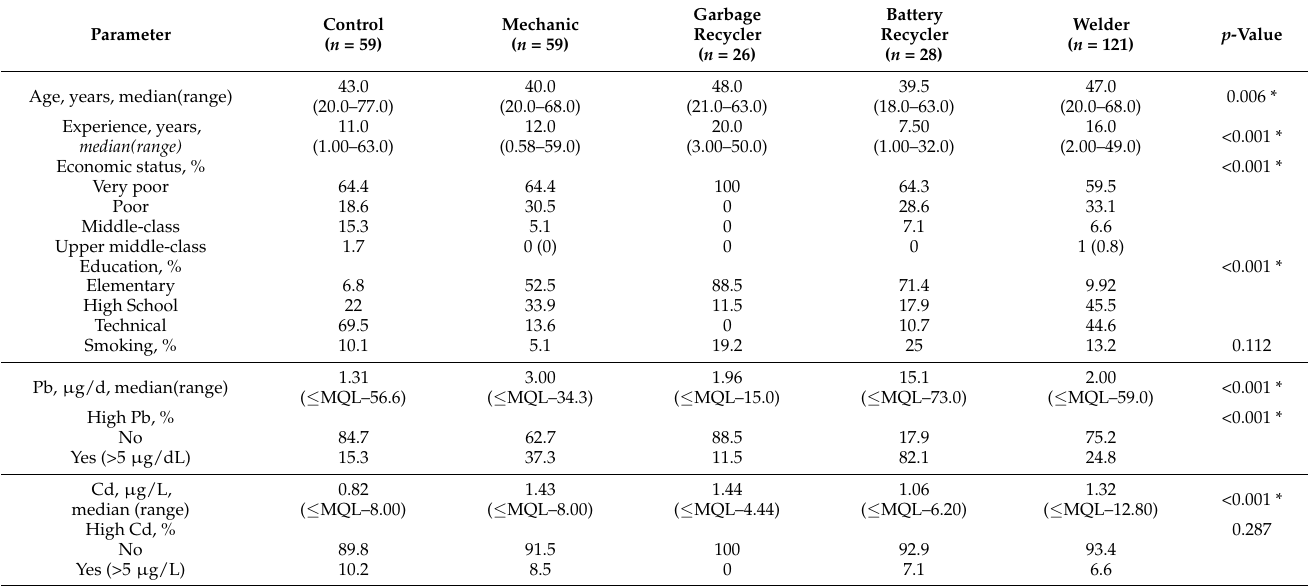
Table 1. Summary of data obtained from subjects from Cartagena, Colombia, stratified by type of